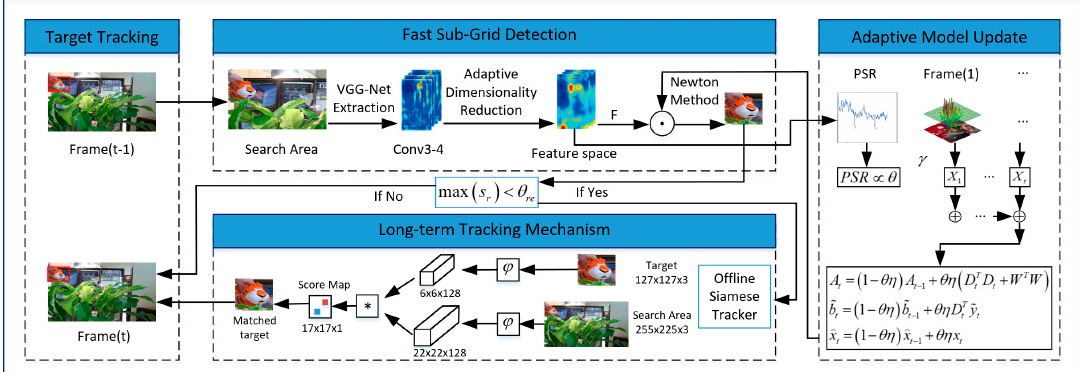
Figure 1. Flow chart of the proposed tracking algorithm.